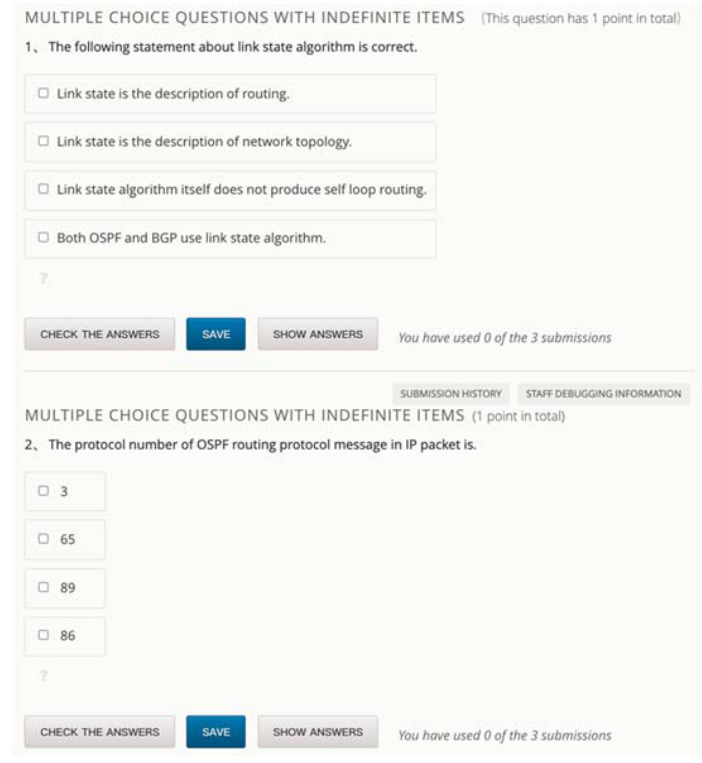
Figure 4. Multiple-choice questions in the network experiment course.